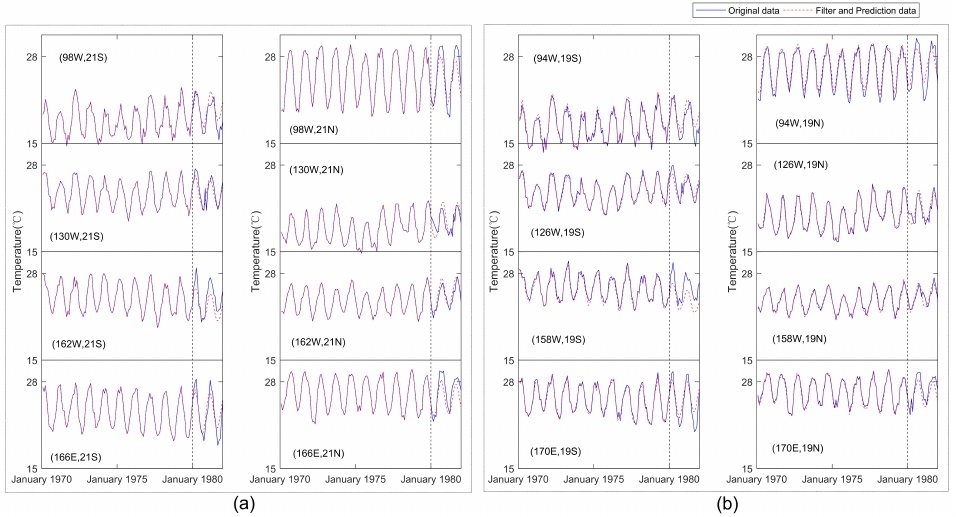
Figure 9. Time-series temperature changes at predicted and original points. Among them, the first 120 months were used for training and the next 24 months were predicted: ( a ) The resampled points; and ( b ) the points estimated though our algorithm, using resampled points.